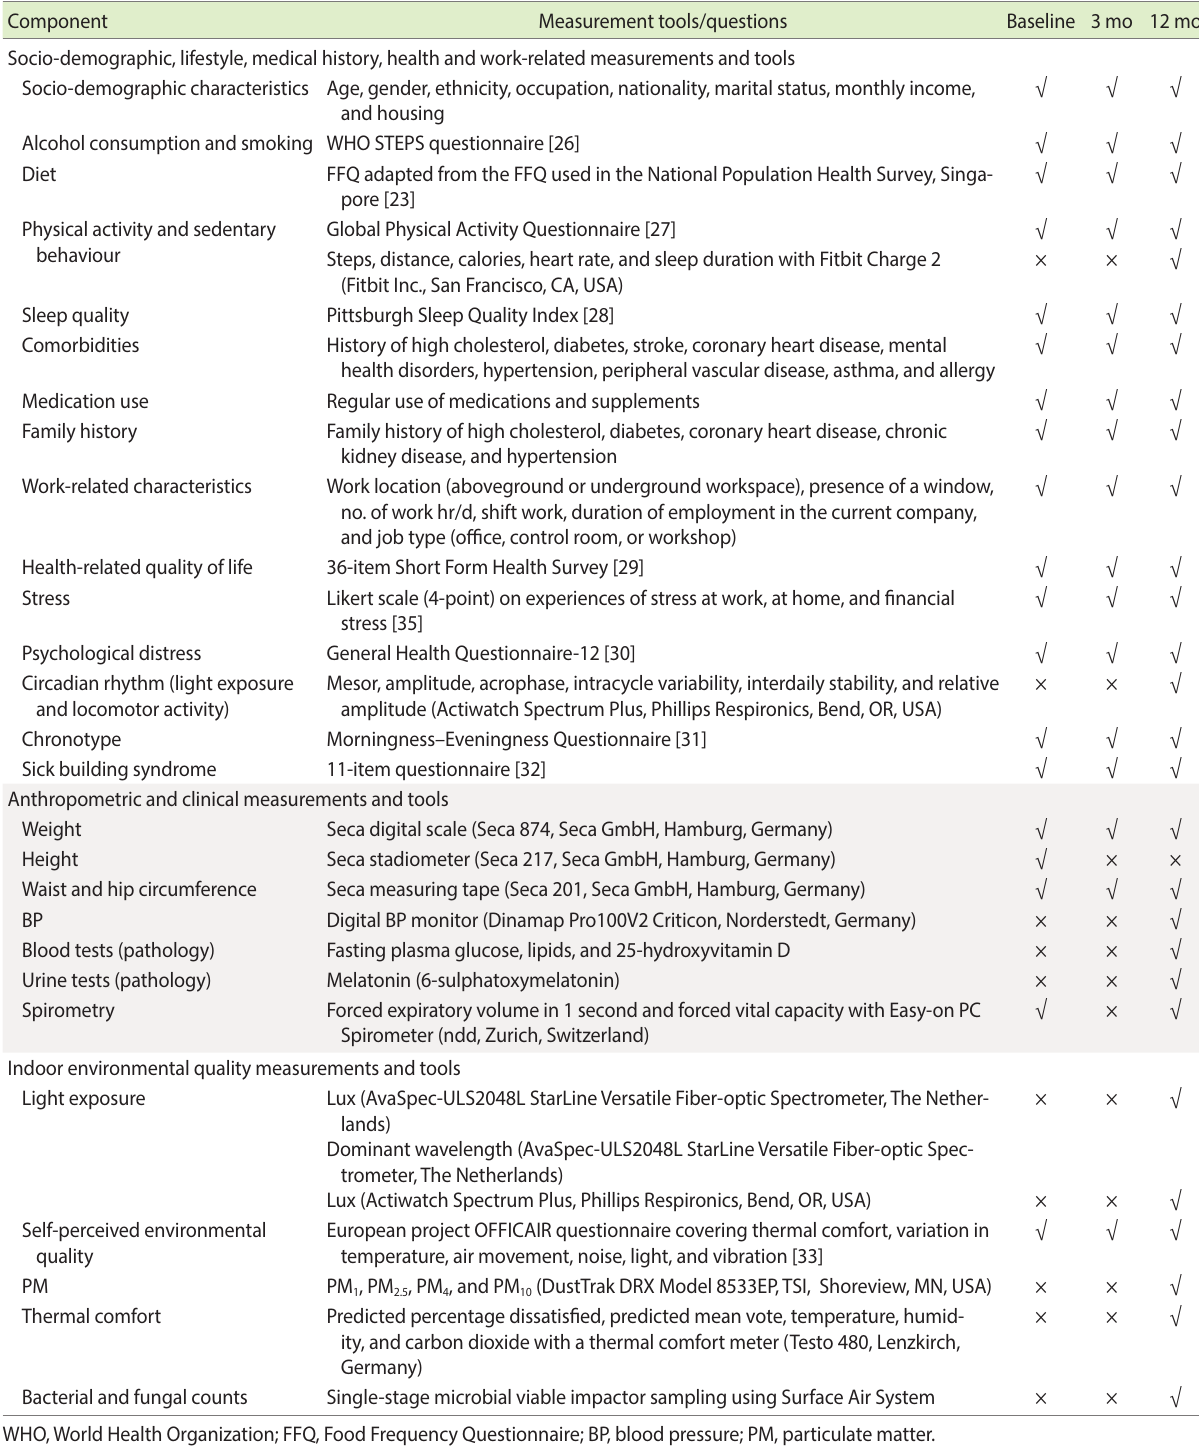
Table 1. Health measurements, tools, and data collection time-points Component Measurement tools/questions Base line 3 mo 12 mo Socio-demographic, lifestyle, medical history, health and work-related measurements and